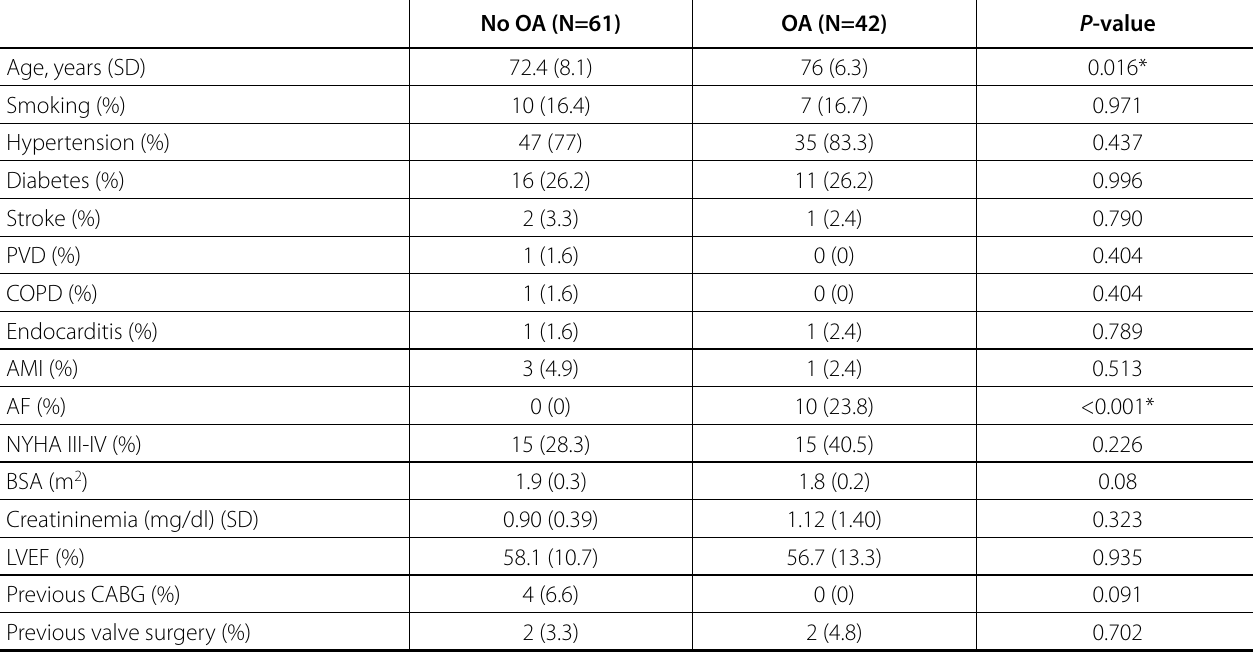
Table 1 . Patients’ preoperative variables.